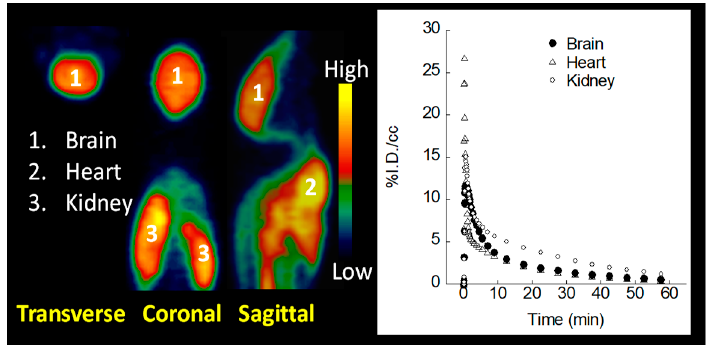
Figure 8. Representative summed (0–10 min) frames microPET images (left panel) from n = 4 male severe combined immunodeficient mice (SCID) mice (~25 g, 3 months old) show that [ 11 C]TH287 had rapid brain uptake and fast clearance in a normal mouse; right panel shows [ 11 C]TH287 time-activity curves in brain, heart, and kidney.